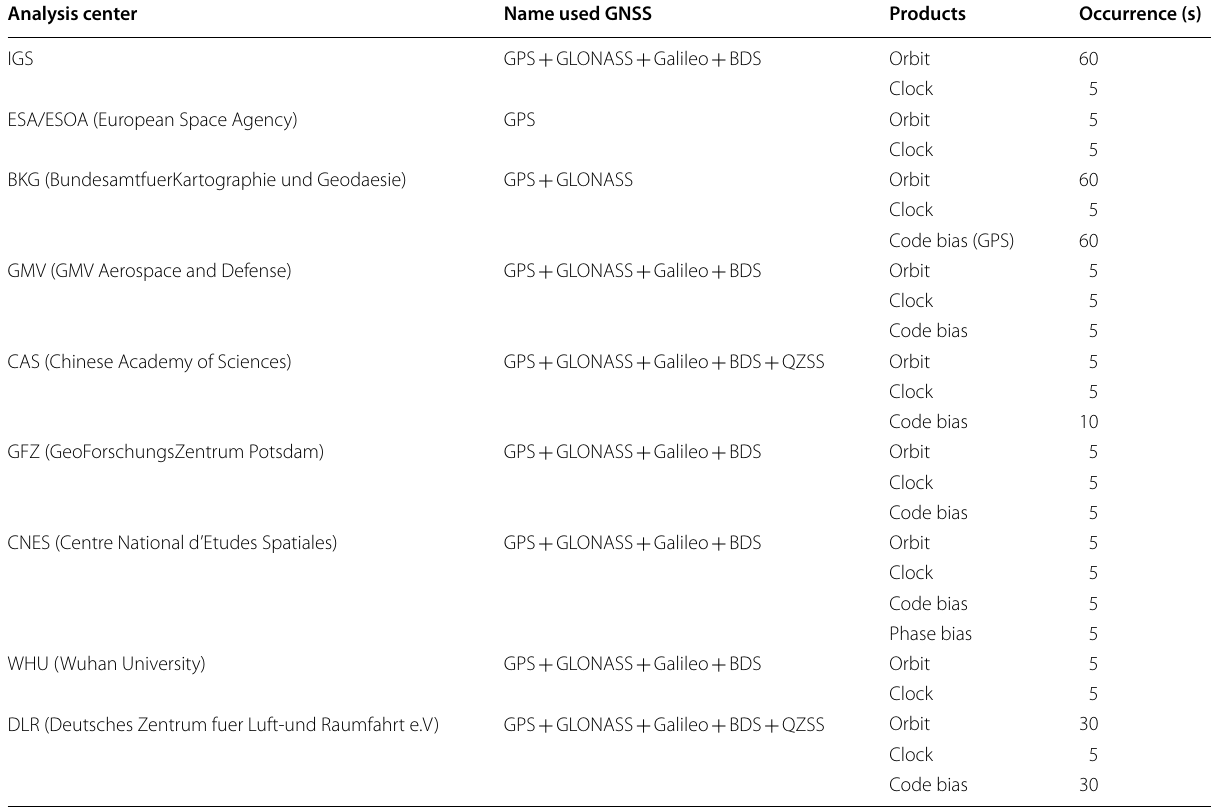
Table 1 Real-time GNSS products of each analysis center Analysis